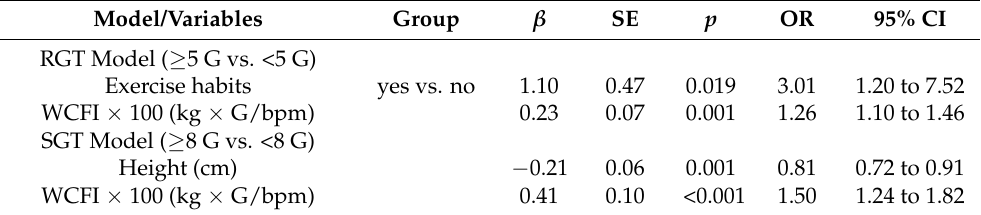
Table 4. Factors associated with G tolerance analyzed by multivariate logistic